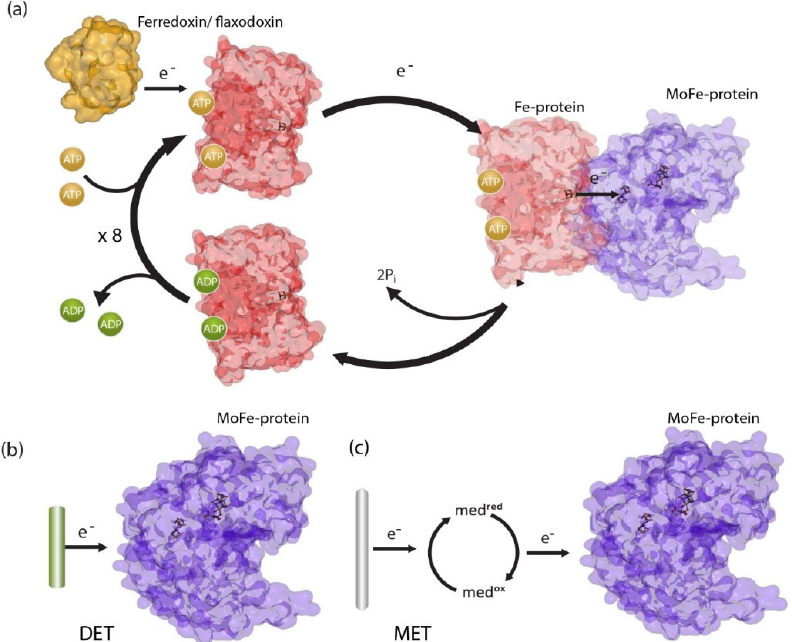
Figure 1. Methods of electron transfer to the Mo ‐ Fe protein: ( a ) Biological electron transfer from a ferredoxin or flavodoxin to the Fe ‐ protein. The Fe ‐ protein provides a single electron to the MoFe ‐ protein and requires the binding of two ATP molecules before an encounter complex with the MoFe ‐ protein can form. Eight electrons are required to convert one molecule of N 2 to two molecules of NH 3 ; therefore, this process must occur eight times, meaning that 16 molecules of ATP are required. ( b ) ATP ‐ free nitrogenase catalysis through Direct Electron Transfer (DET) using either a photoex ‐ cited nanoparticle (light driven) or a modified electrode to provide electrons directly to the MoFe ‐ protein. ( c ) ATP ‐ free nitrogenase catalysis through Mediated Electron Transfer (MET), whereby a mediator is used to shuttle electrons from an electrode to the MoFe ‐ protein.